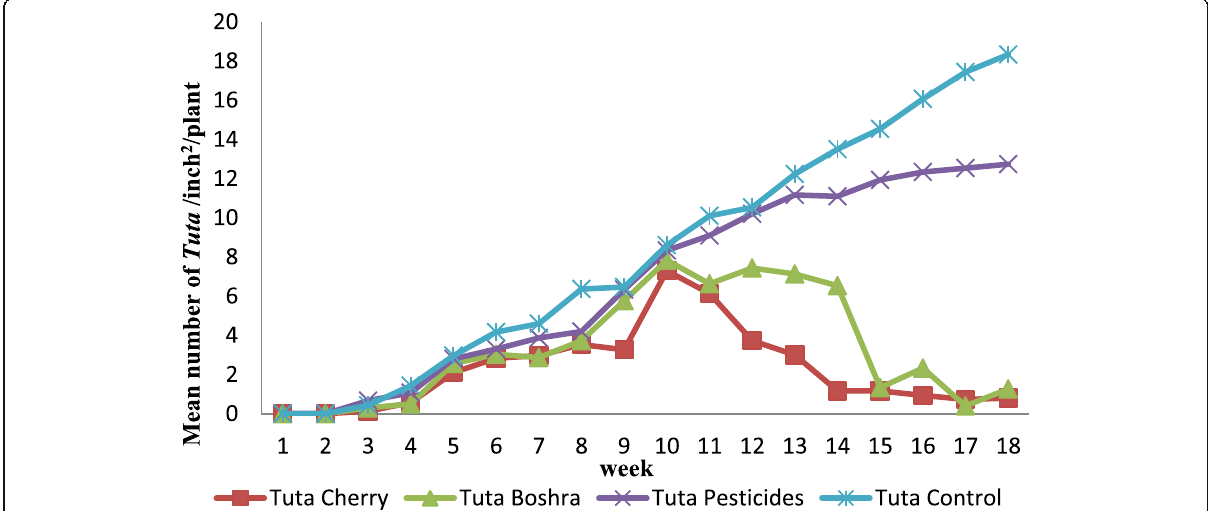
Fig. 2 Mean number of mines of Tuta absoluta larvae in cherry, Boshra, pesticides and control greenhouses in the winter plantation, 2018 –